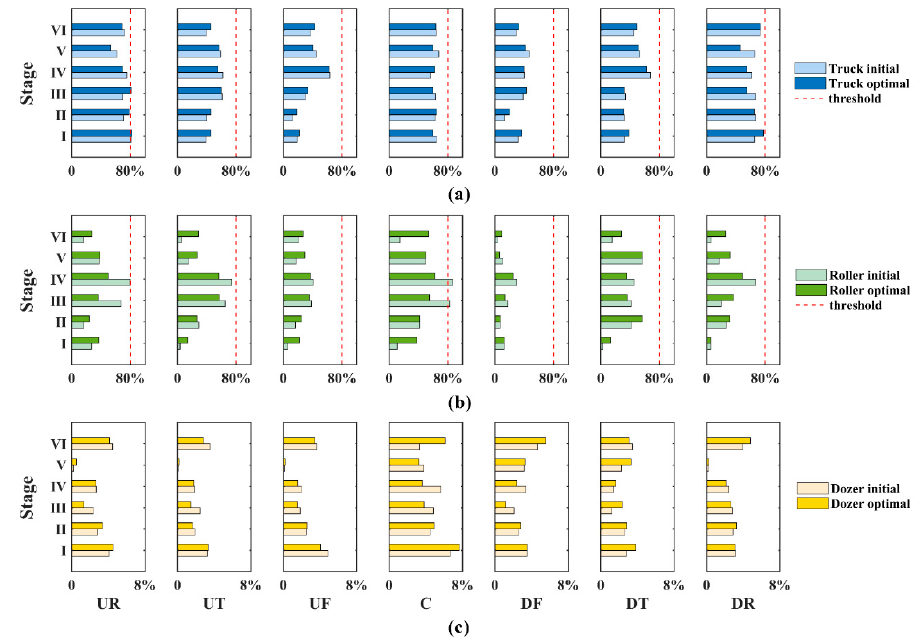
Figure 14. Average machinery utilization rate comparison between the optimal and initial plans. ( a ) Comparison of TUR; ( b ) Comparison of RUR; ( c ) Comparison of DUR.